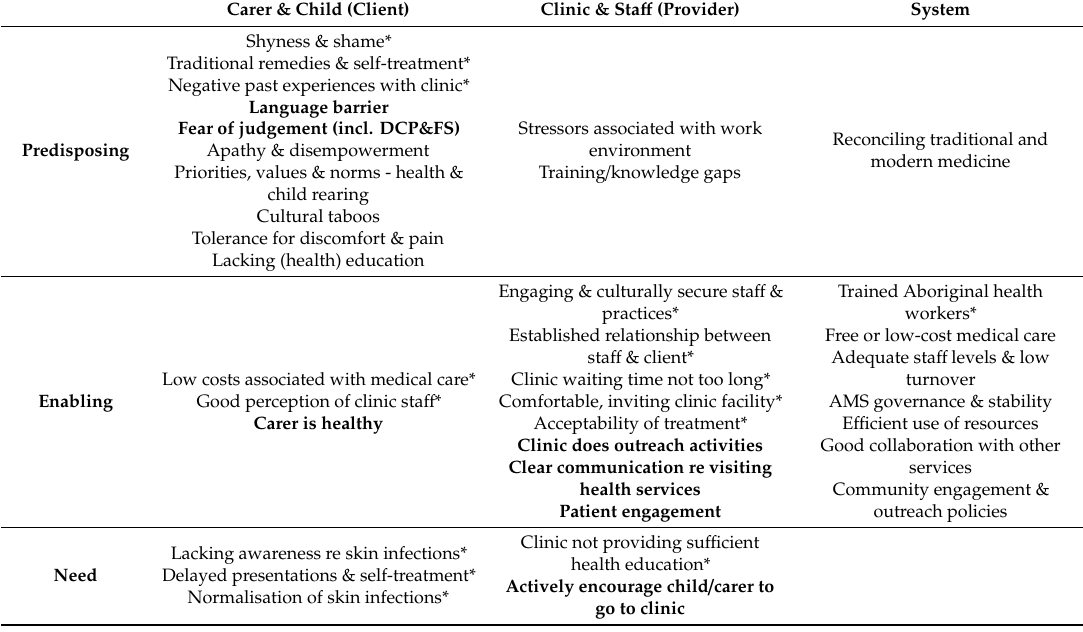
Table 5. Factors that a ff ect health service utilisation in remote Pilbara communities according to other service